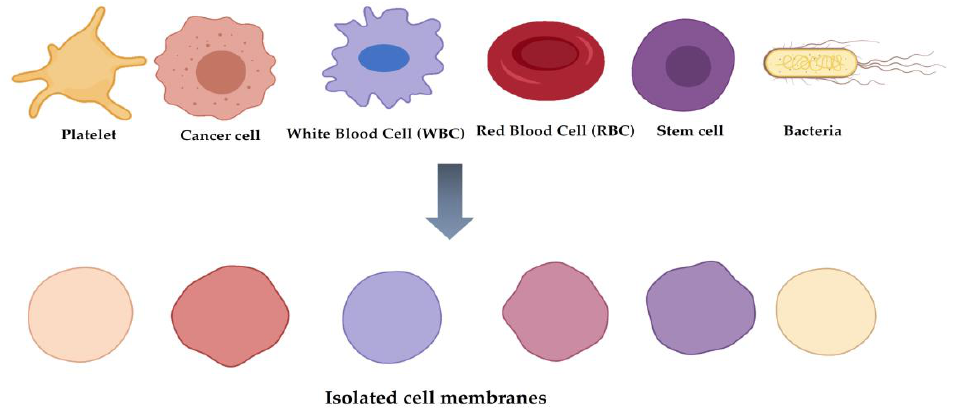
Figure 1. Schematic of different isolated cell